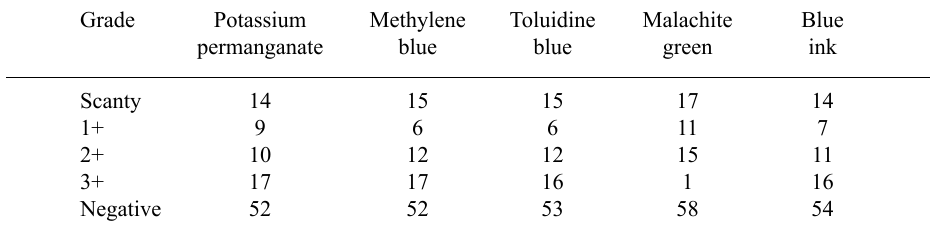
Table 3. Comparison of counter stains in grading the positive